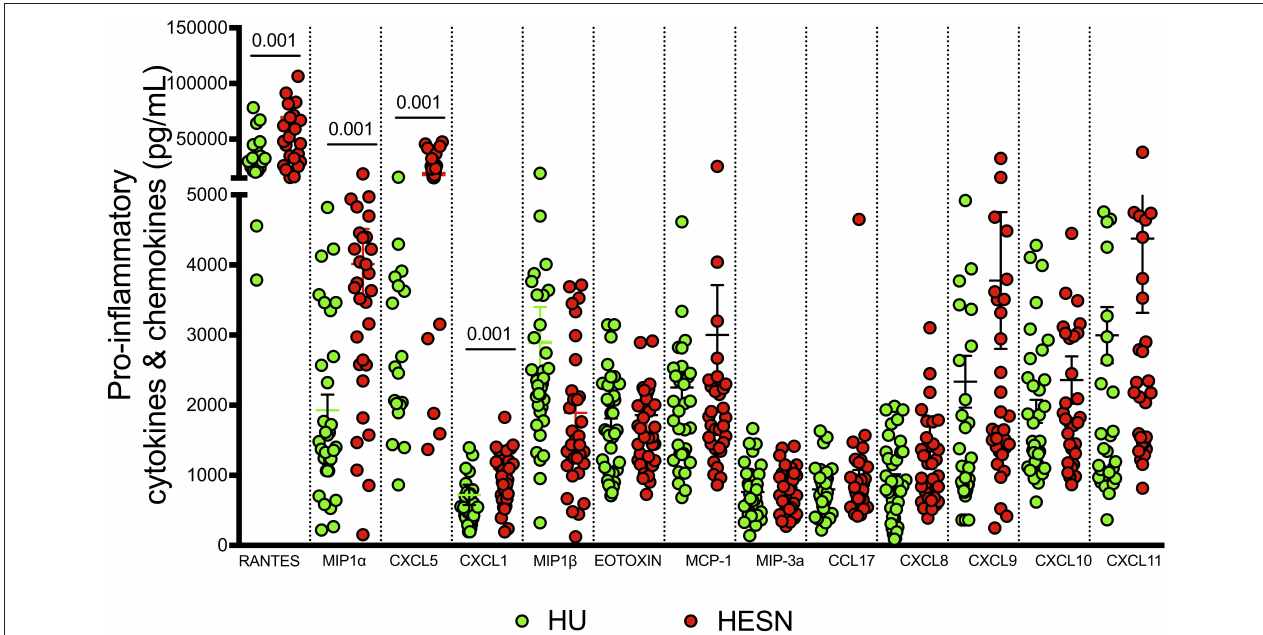
FIGURE 5 | Estimation of pro-inflammatory cytokines and chemokines: Levels of pro-inflammatory cytokines and chemokines were quantified using cytometric bead array among HESN ( N = 35) and HU ( N = 35) groups. The data shown is the median level of cytokines and chemokines [RANTES, MIP- α , ENA-78 (CXCL5), GRO- α (CXCL1), and MIP-1 β ] in plasma (expressed as pg/mL). The scatter dot plots show the median, 25th, and 75th percentiles and range (IQR). P- values were determined using Mann-Whitney’s T- test. (HESN, HIV exposed seronegative; HIV + ART + , HIV-infected women on ART; HIV + ART − , HIV-infected women naïve to ART; HU, HIV unexposed seronegative